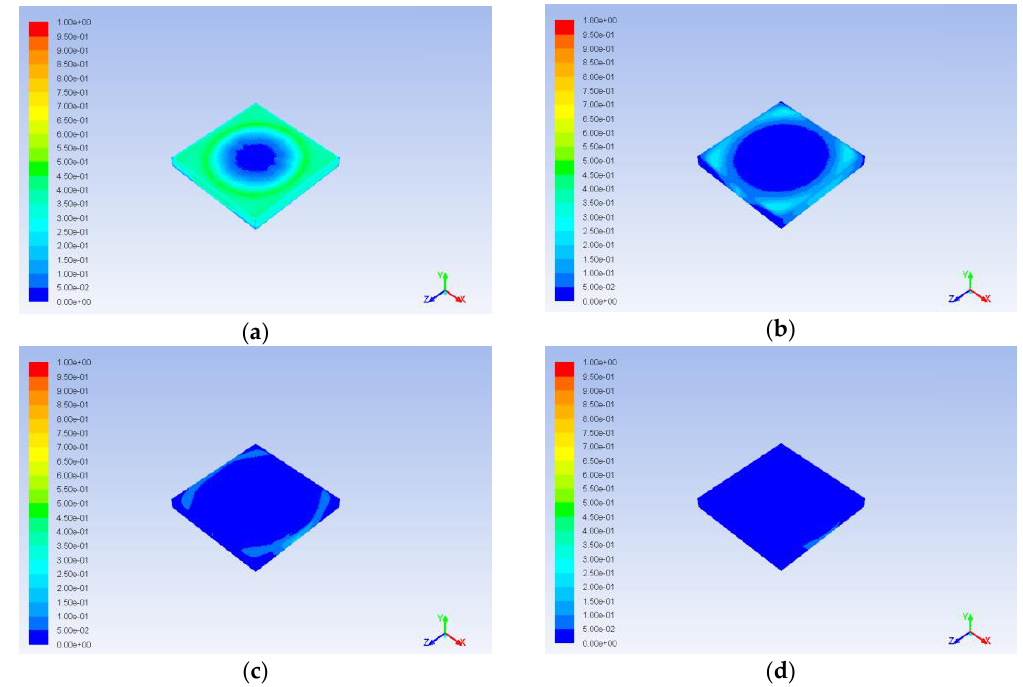
Figure 17. Aniline mass fraction profile (XZ middle cross section, the reactor walls are not shown, maximum value of the color map corresponds to pure aniline): ( a ) 500 seconds, ( b ) 10,000 seconds, ( c ) 20,000 seconds, ( d ) 30,000 seconds.